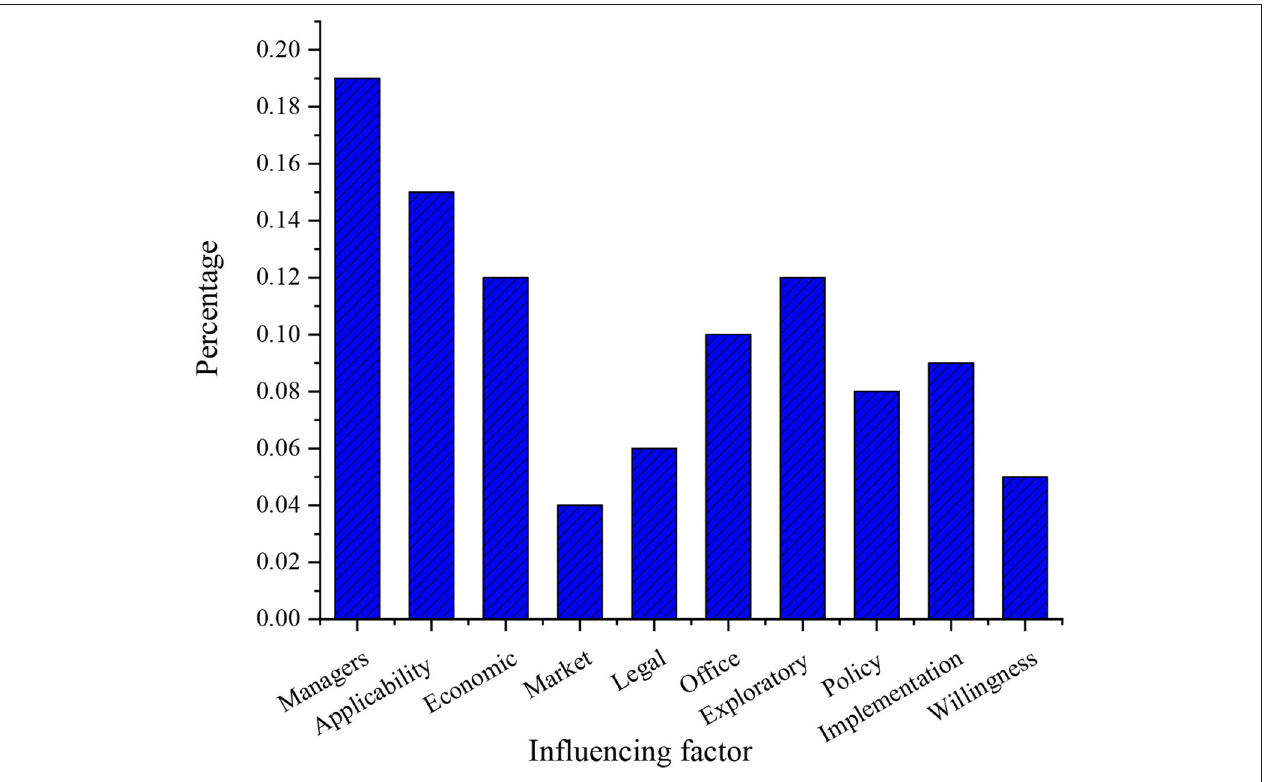
FIGURE 7 | Results of the proportion of various